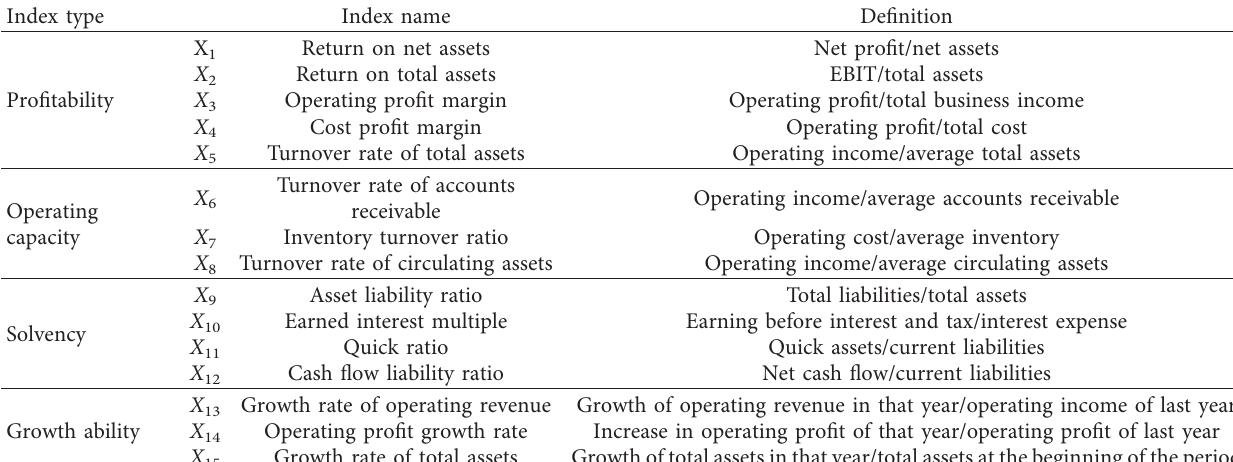
Table 1: Index and definitions.